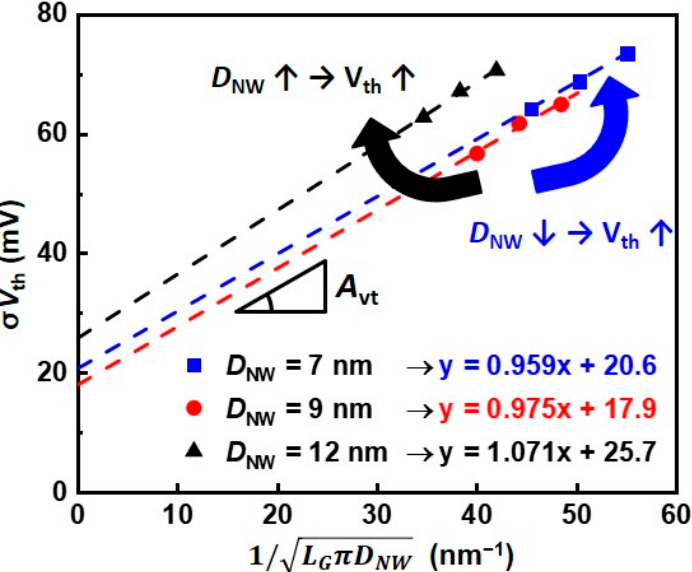
− effect transistors